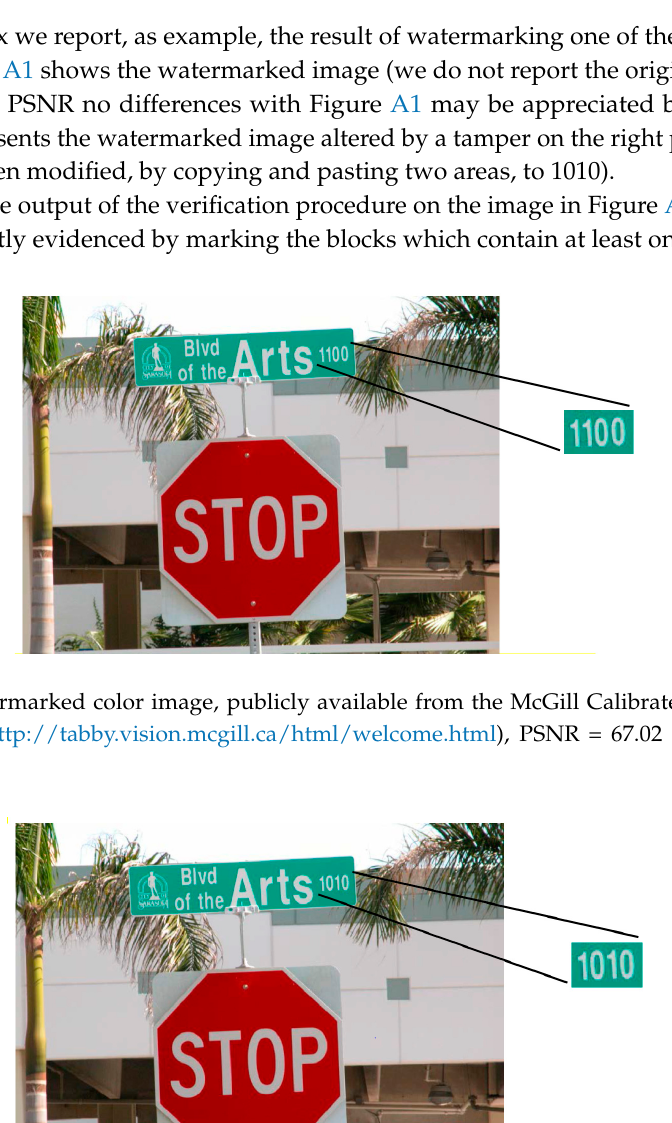
Figure A3. Verified image, with (nineteen) tampered blocks evidenced as crossed areas. References 1.